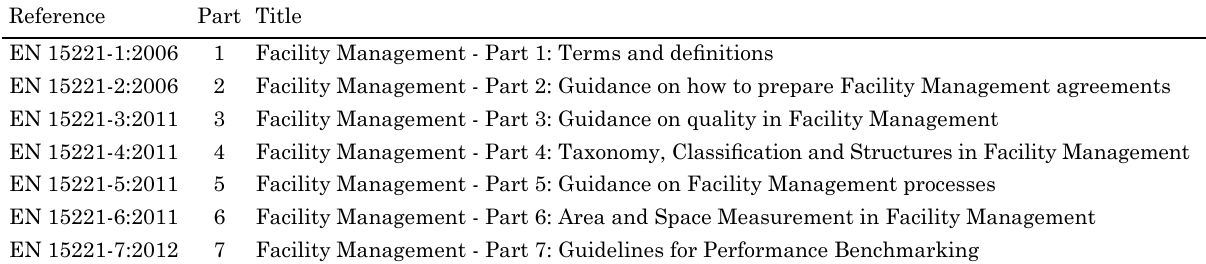
Table 1. CEN/TC 348 Published Standards (CEN/TC 348 2016) Reference